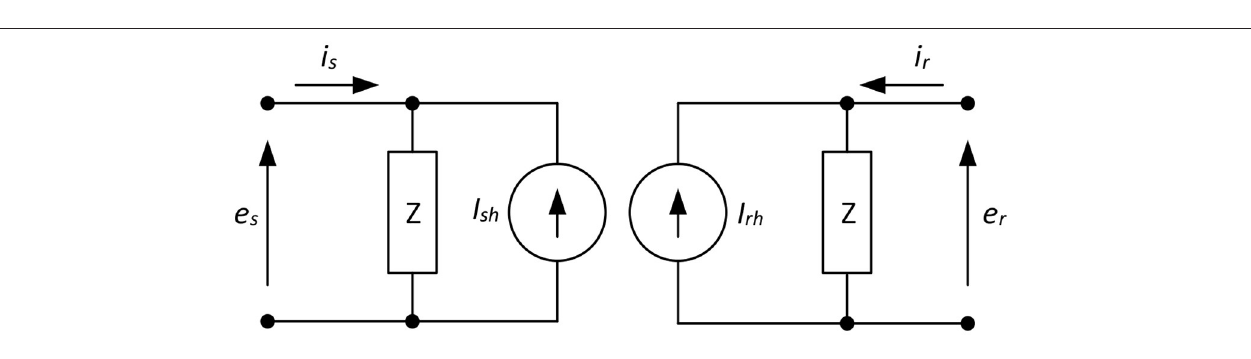
FIGURE 2 | Two-port model of a single-phase distribution